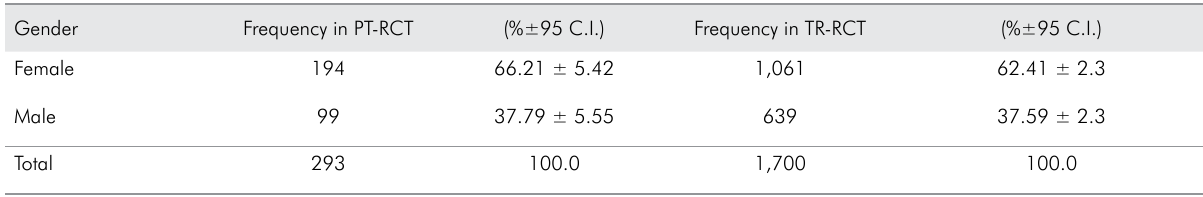
Table 3. Distribution of teeth with apical radiolucency among teeth with previous endodontic treatment (PT-RCT) and among teeth referred for endodontic treatment (TR-RCT) by gender (n = 1,993)